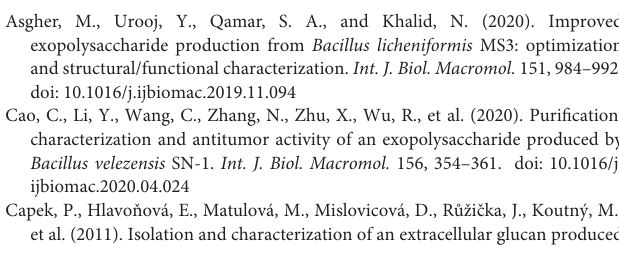
Supplementary Figure 1 | UV–vis spectroscopy scanning of puried EPS-8-2. Supplementary Figure 2 | Infrared scanning results of exopolysaccharide (EPS). Different absorption peaks indicate that the EPS probably has a different structure. Supplementary Figure 3 | Differential scanning calorimetry thermogram of EPS-S-2. The experiment was processed at a temperature range of 0–700 ◦